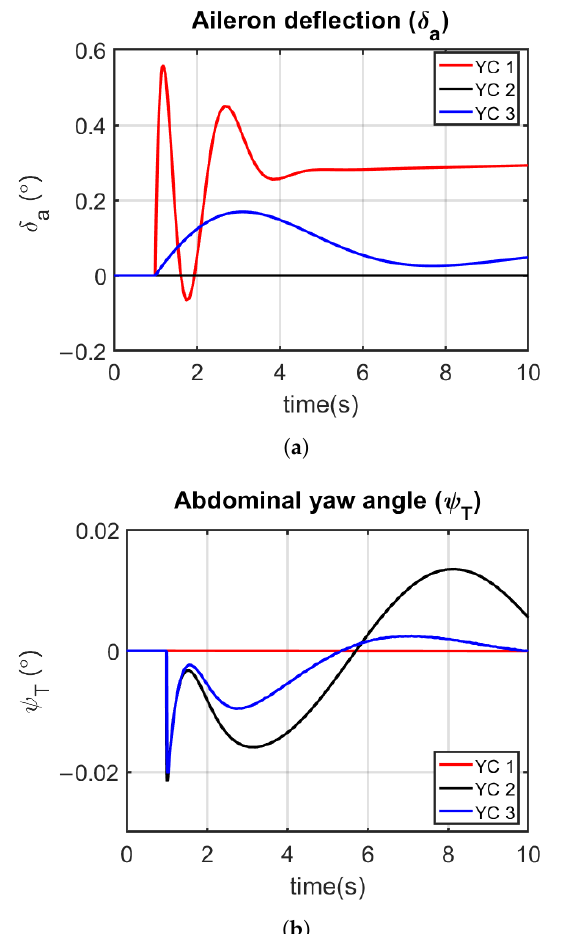
Figure 7. Time histories of the lateral control inputs: ( a ) aileron deflection ( δ a ) . ( b ) abdominal yaw angle ( ψ T )